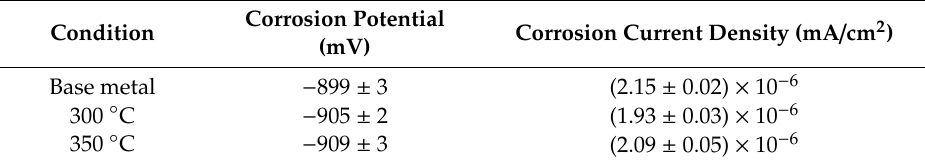
Table 3. Electrochemistry corrosion parameters of 7N01 aluminum alloy in a 1 M NaCl aqueous solution.